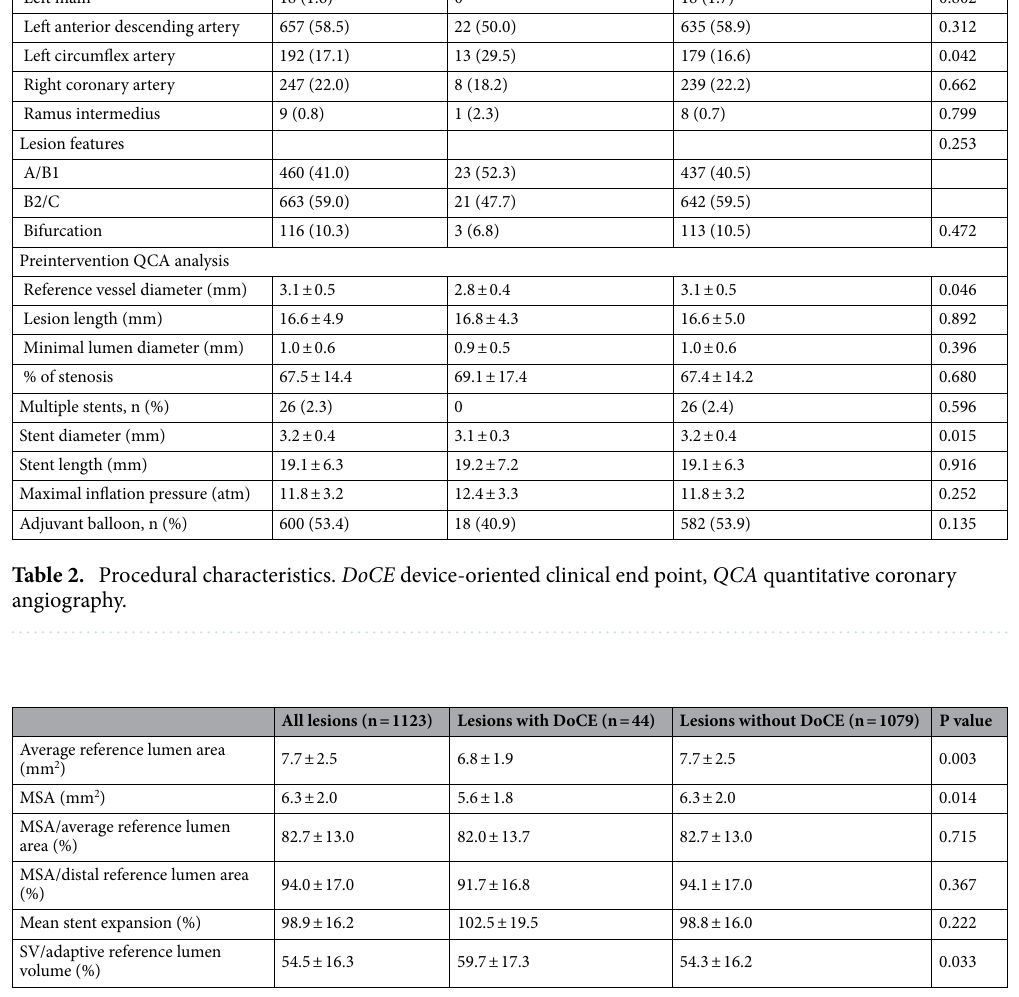
Table 3. Post-stent OCT findings. DoCE device-oriented clinical end point, MSA minimal stent area, OCT optical coherence tomography, SV stent volume.